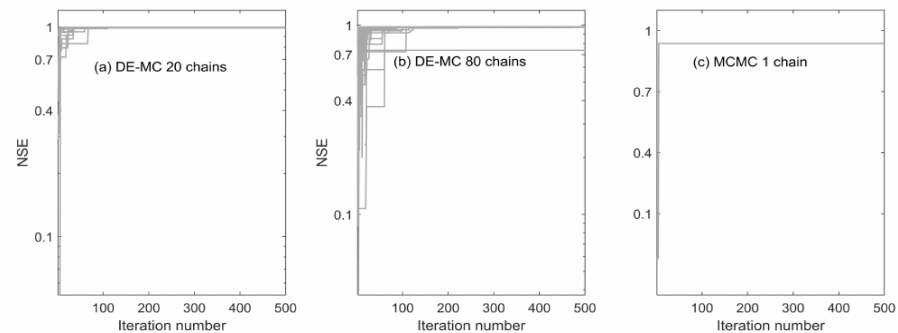
Figure 2. NSE of each iteration step in synthetic experiment: ( a ) DE-MC 20 chains; ( b ) DE-MC 80 chains; ( c ) MCMC 1